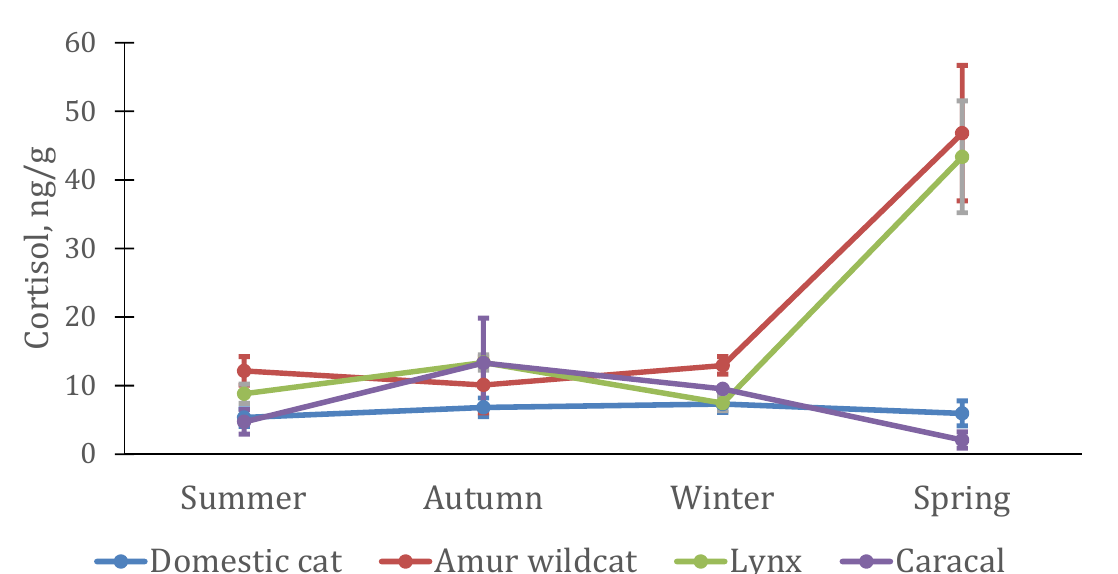
Figure 5. Cortisol concentration in hairs from four male felid species ( n = 5 domestic cats, n = 4 lynx, n = 4 Amur wildcats, n = 4 caracals).